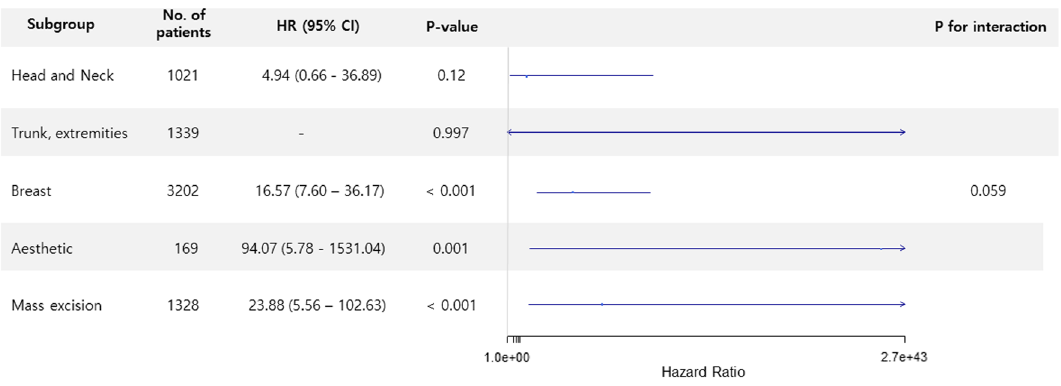
Figure 3. Forest plot of subgroup analysis according to type of